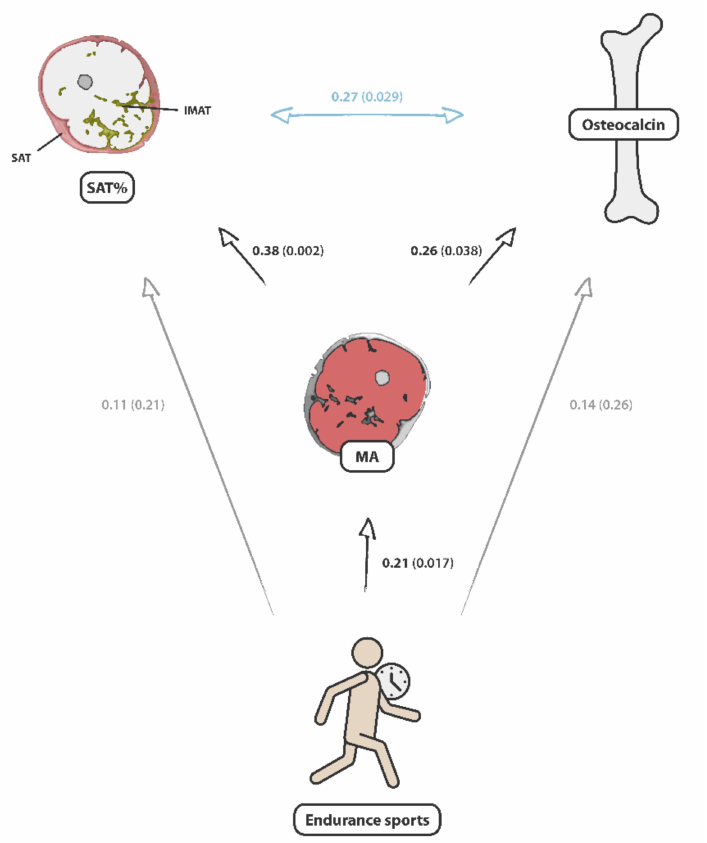
Figure 4. Overview of the interrelationships between SAT/(SAT + IMAT), cross-sectional muscle area, serum osteocalcin, and endurance training. The strength of relationships is given by the Pearson’s correlation coefficients and the corresponding p -values (cc ( p